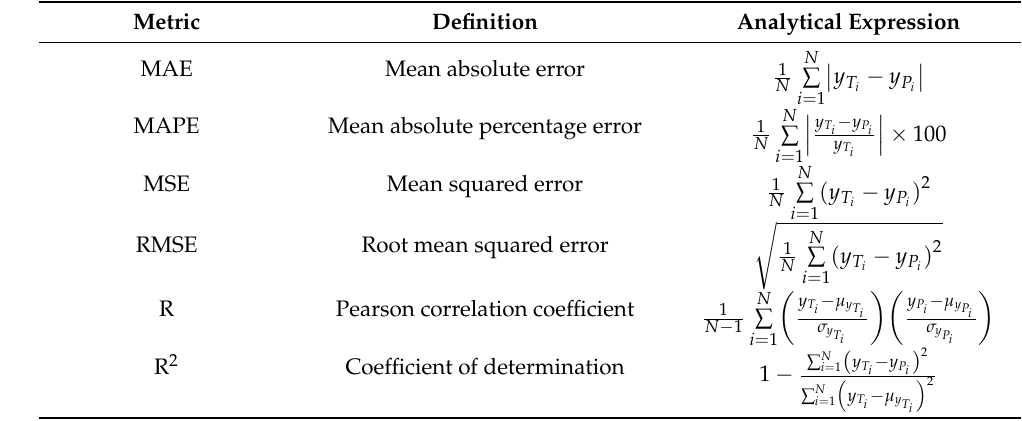
Table 5. Performance